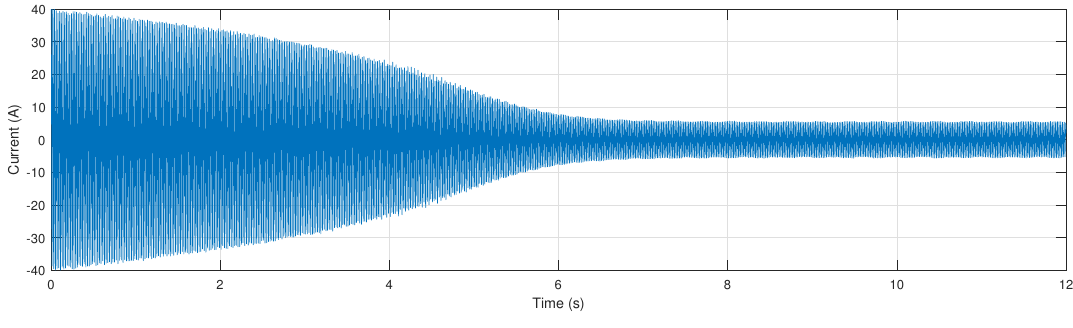
Figure 8. Start-up current of the motor of Appendix A with a broken bar